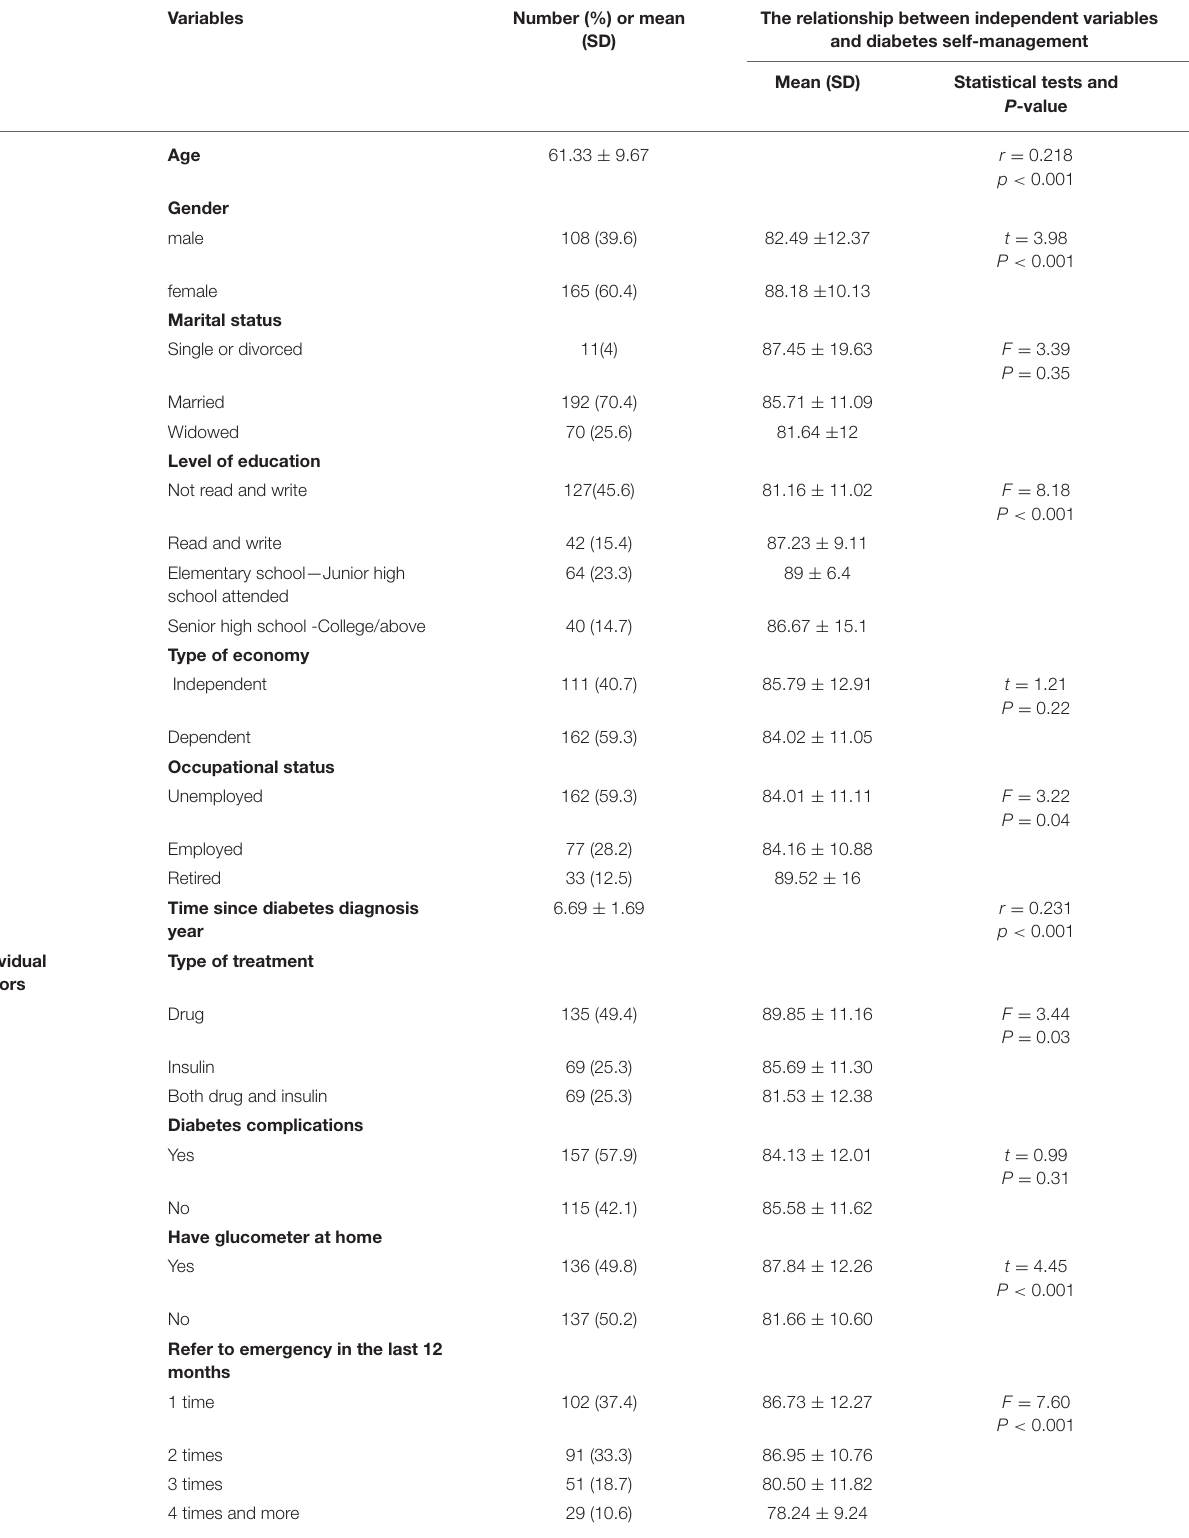
TABLE 1 | Descriptive table of independent variables and their relationship with self-management. Variables Number (%) or mean